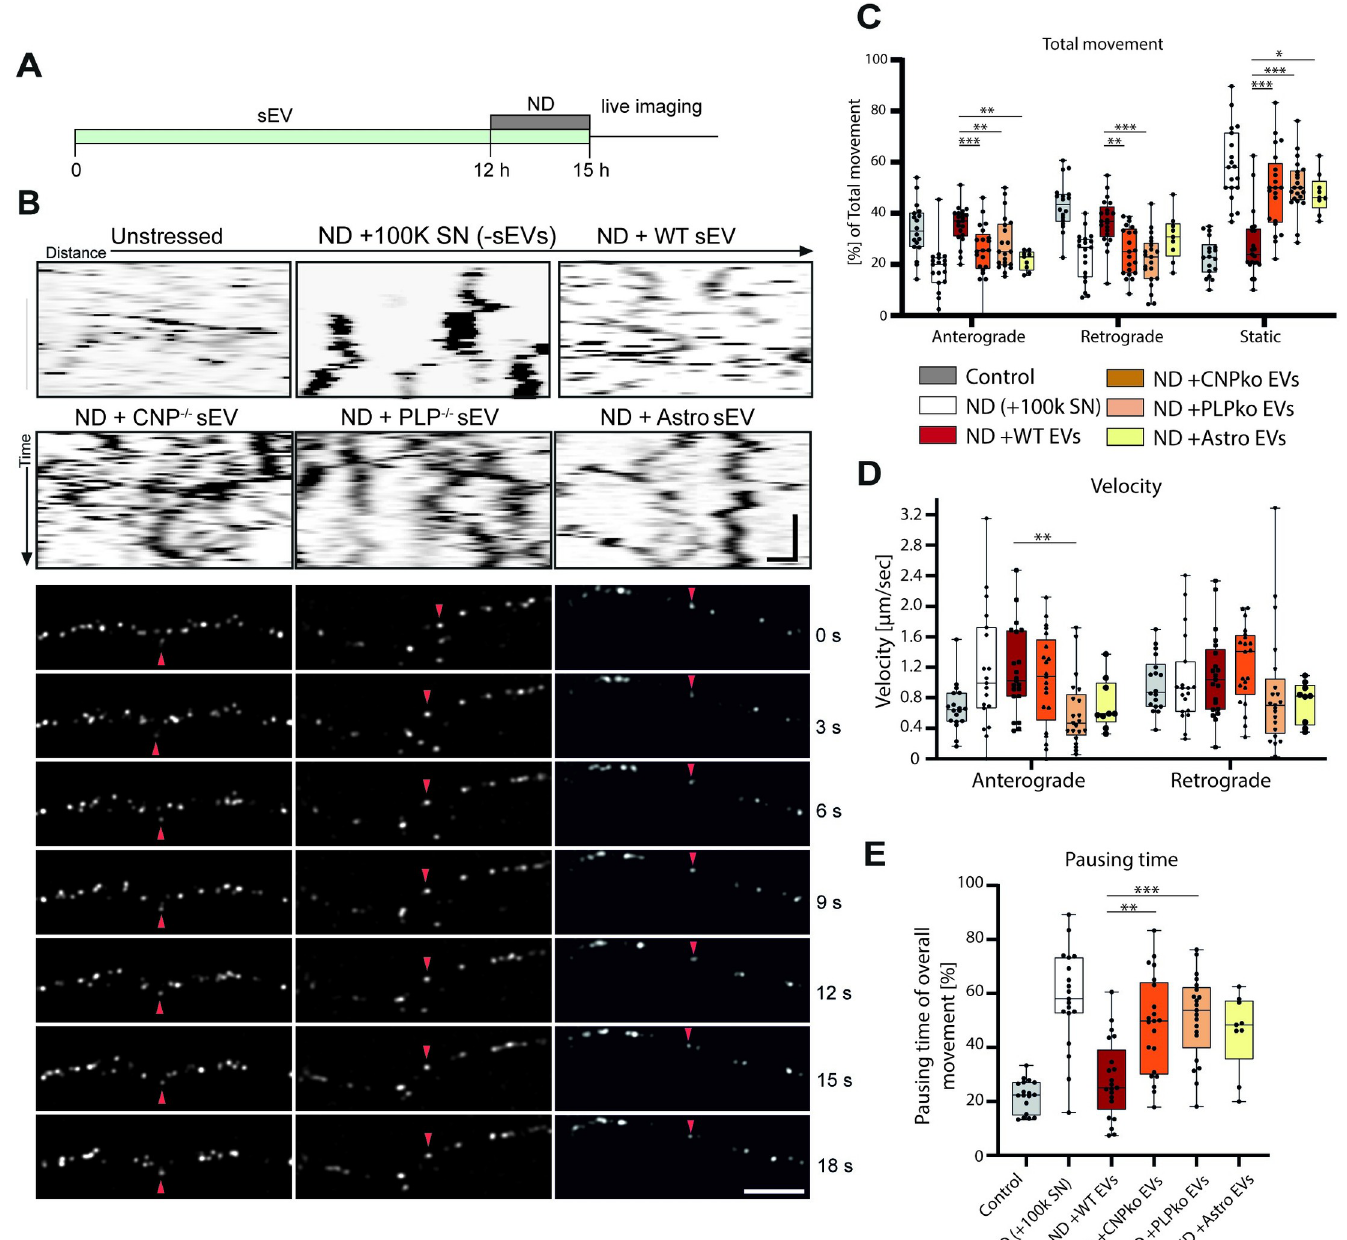
Fig 6. PLP- and CNP-null exosomes do not promote axonal transport under starvation stress. (A) Illustration of experimental schedule. Hippocampal neurons were treated with sEVs and subjected to starvation stress by depletion of B27 supplement (nutrient deprivation) during the last 3 h before live imaging. All treatment conditions were identical regarding the presence of oligodendrocyte-derived soluble factors and differed in presence of sEVs. (B) Representative kymographs and corresponding time-lapse frames illustrating movement of BDNF-mCherry-positive vesicles generated from hippocampal neurons exposed to nutrient deprivation and treated with sEVs derived from wild-type (WT), CNP knockout (CNPko), and PLP knockout (PLPko) oligodendrocytes or primary astrocytes (Astro). Red arrowhead follows 1 distinct particle moving over time. Kymograph: horizontal scale bar = 5 μ m, vertical scale bar = 10 s; fluorescent picture frames: scale bar = 5 μ m. (C–E) Quantitative analysis of kymographs regarding total movement (C), velocity (D), and pausing time (E) of BDNF-mCherry-positive vesicles. Data from control, ND + 100K SN and ND + WT EVs are reproduced from Fig 2 as reference. Data are presented as median, boxes (25th percentile to 75th percentile), and whiskers (minimum to maximum showing all data points), n = 18 recorded neurons for control, n = 19 for ND + 100K SN ( − sEVs); n = 21 for ND + WT sEVs, ND + PLPko sEVs, and ND + CNPko sEVs; and n = 9 for ND + astrocyte sEVs, with up to 50 vesicle trajectories analyzed per neuron, derived from 3 independent experiments. � p < 0.05, �� p < 0.01, ��� p < 0.001, Shapiro–Wilk normality test following Kruskal–Wallis test with Dunn’s multiple comparison test. Significance only indicated for wild- type versus mutant sEVs for reasons of clarity (see Fig 2 for wild-type significance). Underlying data can be found in S1 Data. 100K, 100,000 g- centrifuged; Astro, astrocyte; CNP, 2 0 ,3 0 -cyclic nucleotide 3 0 -phosphodiesterase; ND, nutrient deprivation; OL, oligodendroglial; pCN, primary cortical neuron; PLP, proteolipid protein; SN, supernatant; sEV, small extracellular vesicle; WT, wild-type.